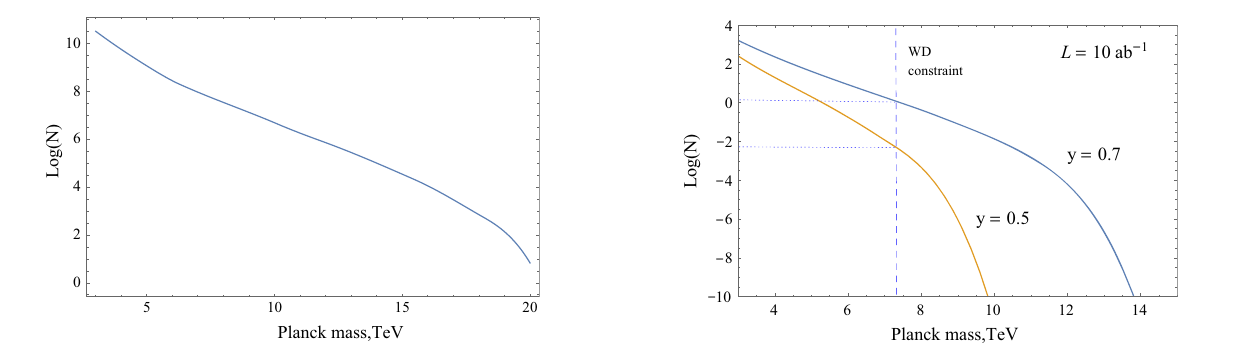
Fig. 7 Upper bound on the amount of the black holes, produced due to hypothetical high energy neutrino collisions with a neutron star with a radius 10 km during 10 million years and stopped by it in the article [16] it was found that above the process thresh- old E th ∼ 2 . 2 · 10 16 · ( B cr / B ) eV an asymptotic neutrino absorption length is l ∼ 1 . 1 · ( B cr / B ) 2 · ( 10 16 eV / E ) m,